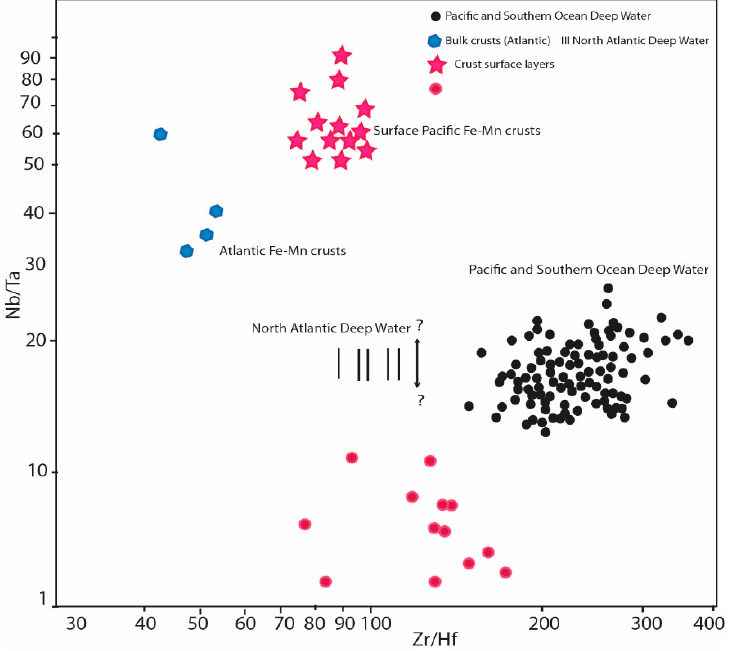
Figure 7. Nb/Ta and Zr/Hf ratios in Mazıda˘gı phosphates compared to Pacific and Arctic deep water and North Atlantic deep water. Data from [50,54,55,60,61].